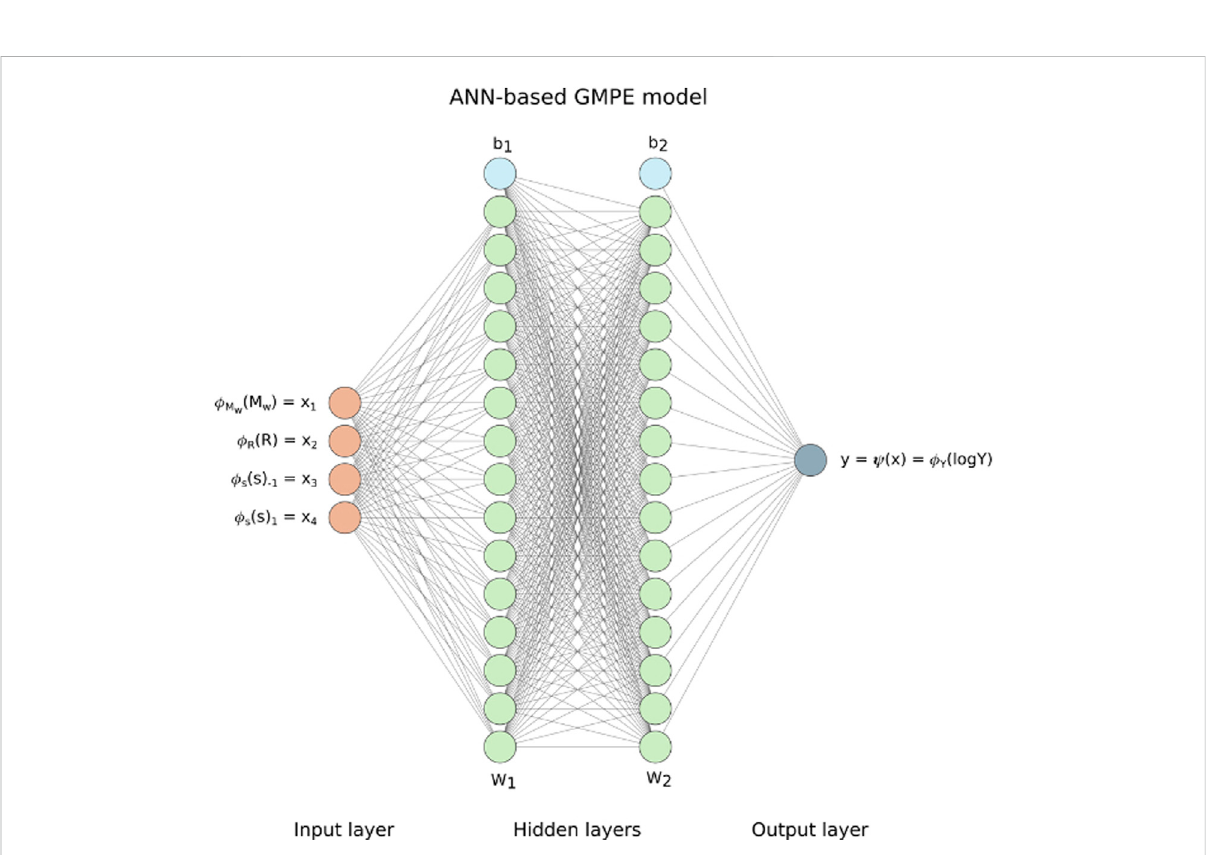
FIGURE 4 Proposed ANN architecture for the GMPE model. It is made of two hidden layers made of 16 neurons in each layer. W 1 , W 2 , b 1 , and b 2 are the parameters from Eq. 3.